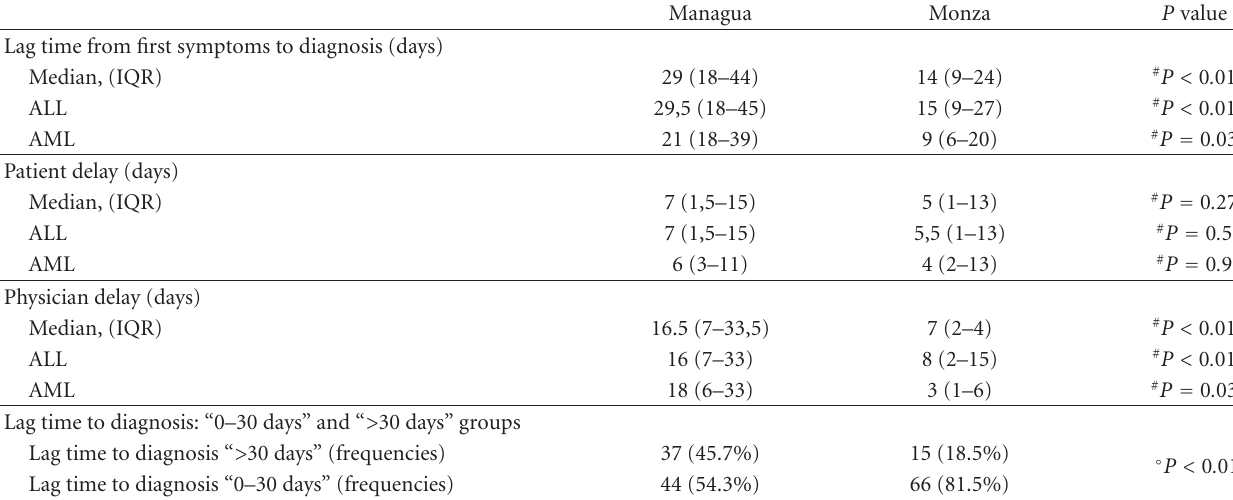
Table 1: Time intervals from first symptoms to diagnosis of leukemia. Managua Monza